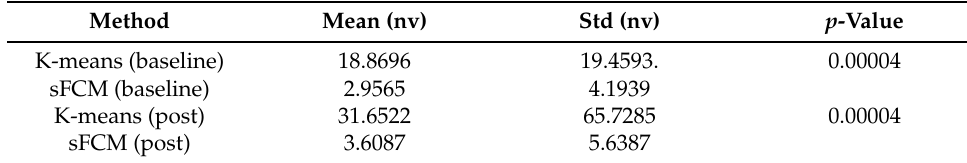
Figure 7. Segmentation of the CC for healthy and SCA2 brain images using K-means and sFCM. Table 5. Mean and standard deviation (Std) of nv.